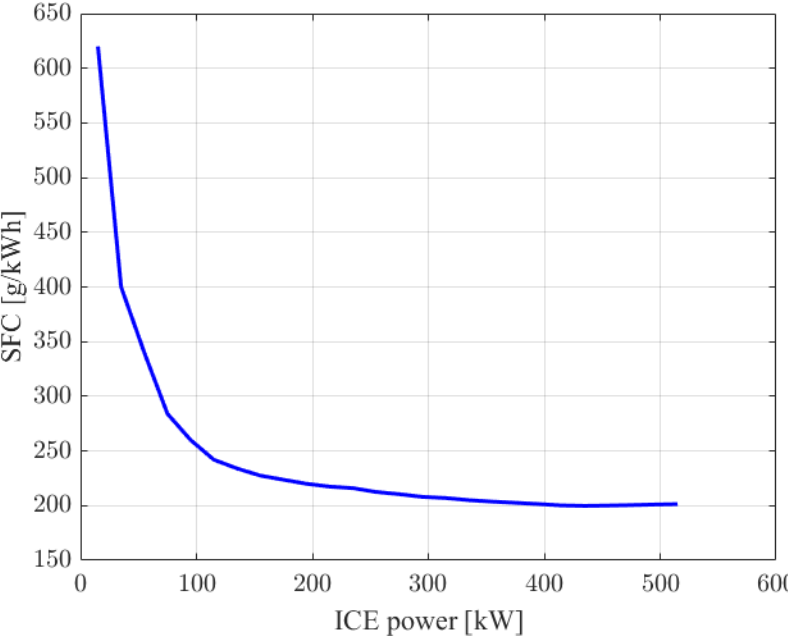
Figure 5. Specific fuel consumption of the ICE, referred to n = 1800 RPM.